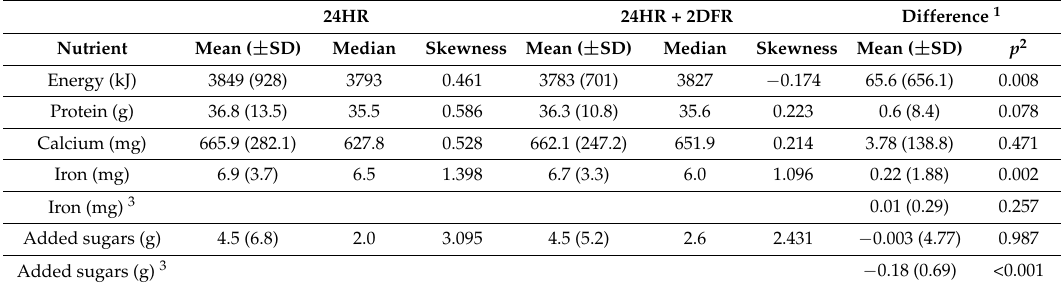
Table 1. Average daily intake of key nutrients reported in the 24HR and the 24HR + 2DFR, and differences in intakes between the 24HR and 24HR + 2DFR in Australian toddlers aged 12 months ( n = 699). 24HR 24HR + 2DFR